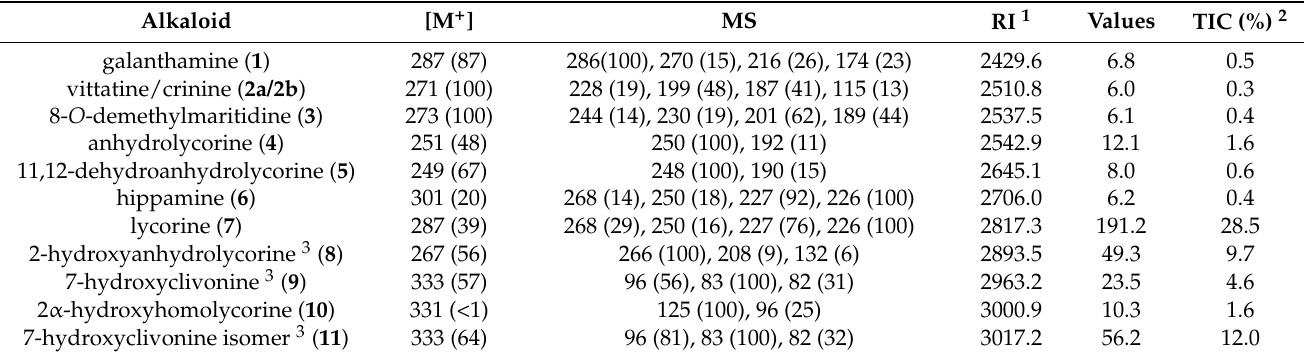
Table 1. GC-MS alkaloid profiling of Clinanthus milagroanthus collected in Peru. Values expressed as mg GAL · g − 1